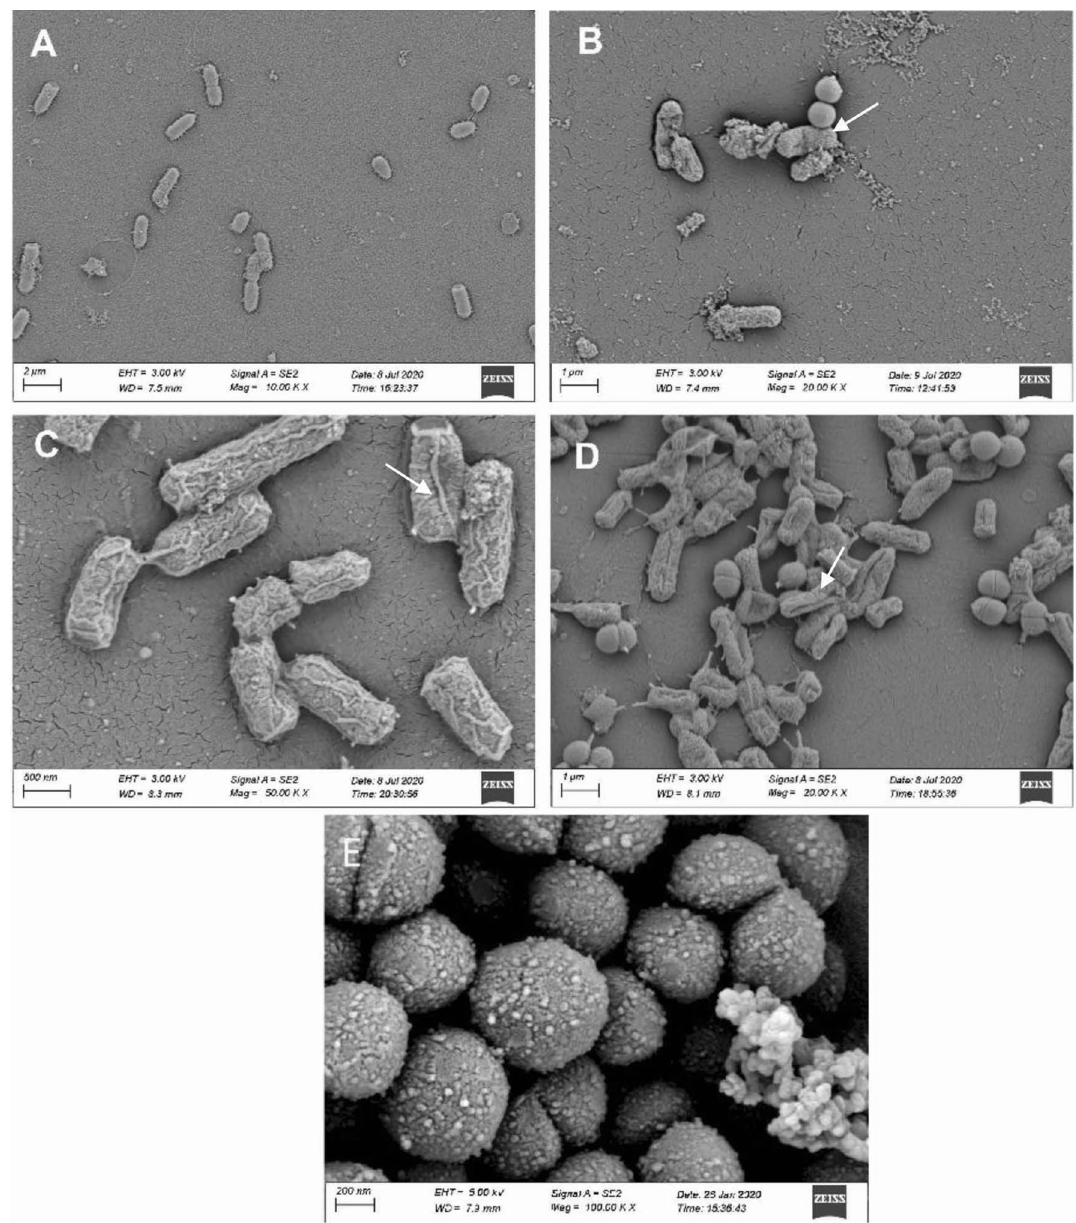
Figure 3. The Electron microscopy of P. acidilactici after 6 h of pathogen challenge in nutrient broth at 37 °C. ( A ) E. coli O157:H7 (ATCC 43894) grew independently as a control. ( B ) E. coli O157:H7 inoculated together with P. acidilactici . ( C ) S. Typhimurium (ATCC 14028) grew separately as a control. ( D ) S. Typhimurium (ATCC 14028) inoculated with P. acidilactici . ( E ) P. acidilactici grew independently without any pathogen